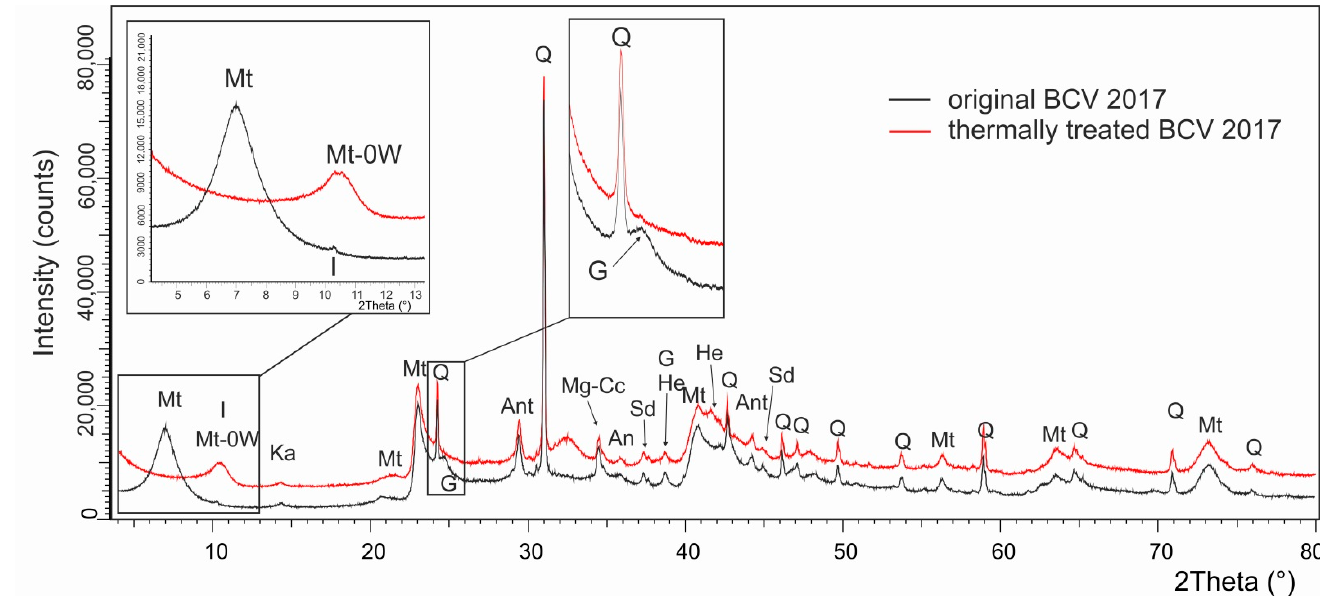
Figure 1. Comparison of the PXRD patterns of the original and thermally treated (200 °C) BCV 2017 (Co K α radiation). The left inset illustrates the change in the 001 reflection of montmorillonite following thermal treatment; the right inset illustrates the disappearance of the goethite reflection following heating. (Mt = montmorillonite, Mt-0W = dehydrated montmorillonite, Ka = kaolinite, Q = quartz, I = illite, Ant = anatase, G = goethite, He = hematite, Mg-Cc = Mg-calcite, Sd = siderite, An = ankerite). Table 2. Semiquantitative PXRD phase analysis of the original and the thermally treated BCV 2017 bentonite (in wt.%).